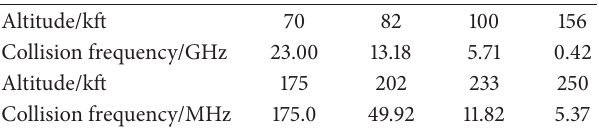
Table 1: Collision frequencies in different typical altitudes ( 𝑇 = 2000 K).